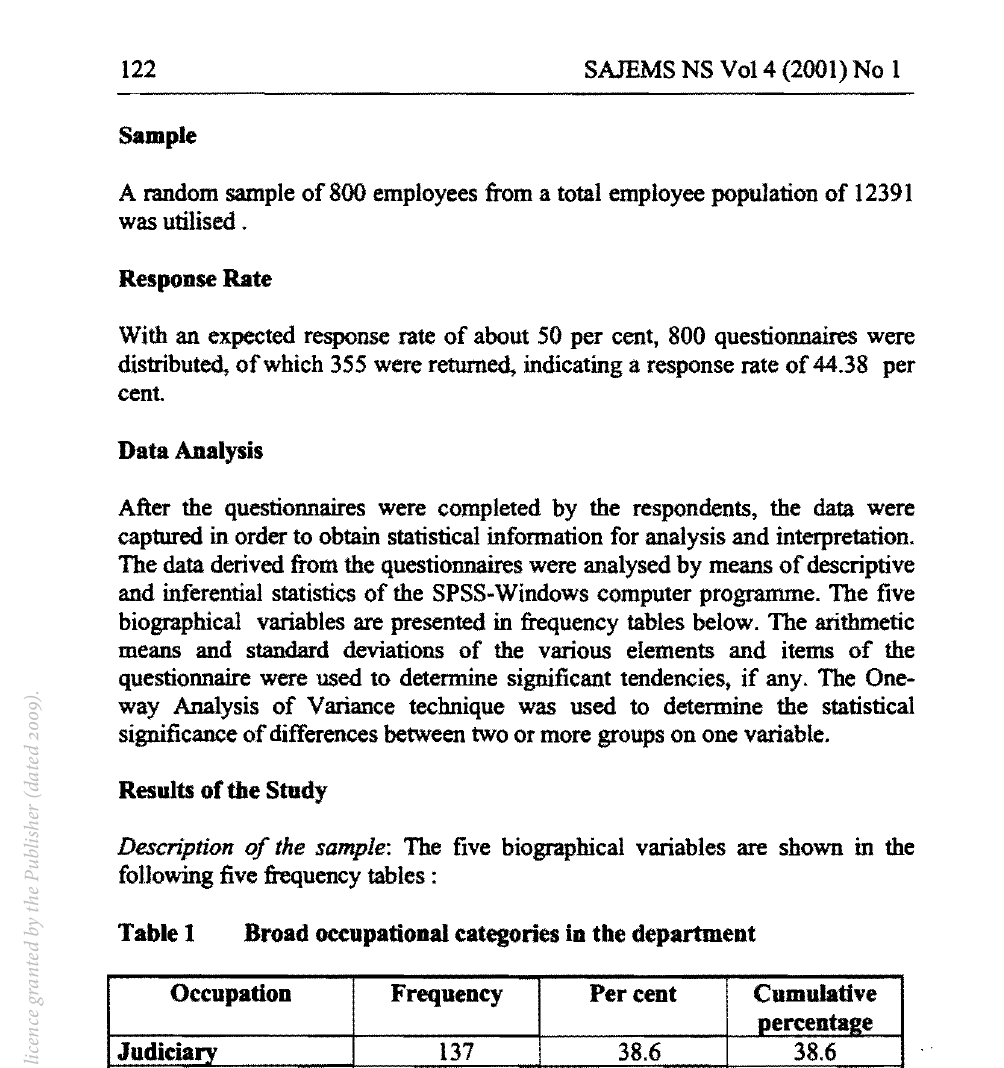
Broad occupational categories in the